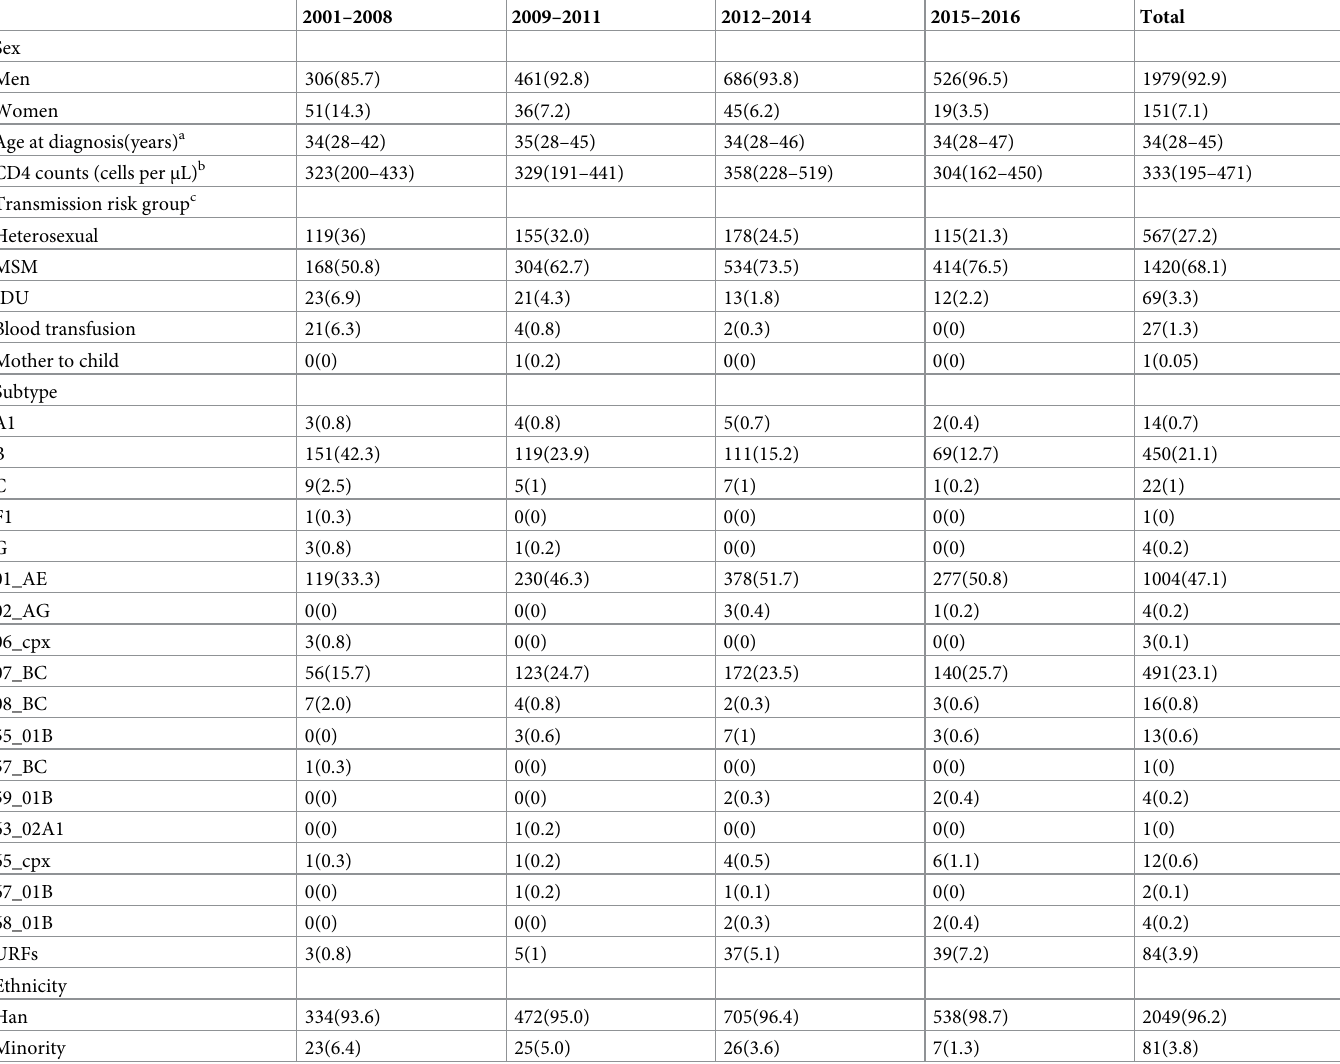
Table 1. Baseline characteristic by sampling